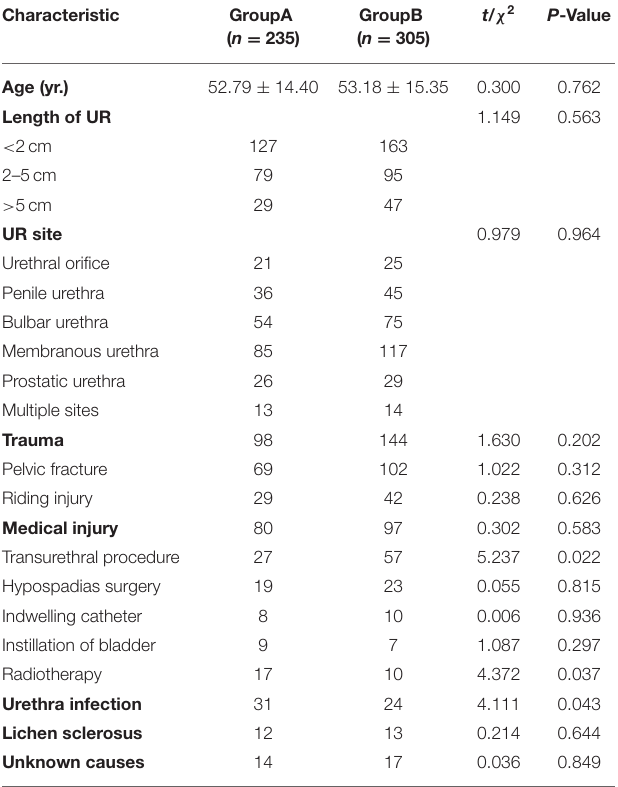
t/ χ 2 P -Value GroupB ( n = 235) ( n = 305)